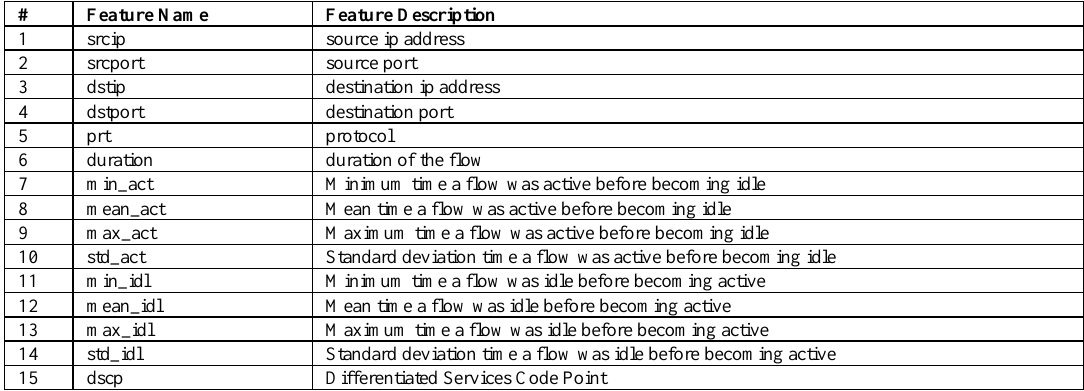
Table 3. Feature description of packets having no